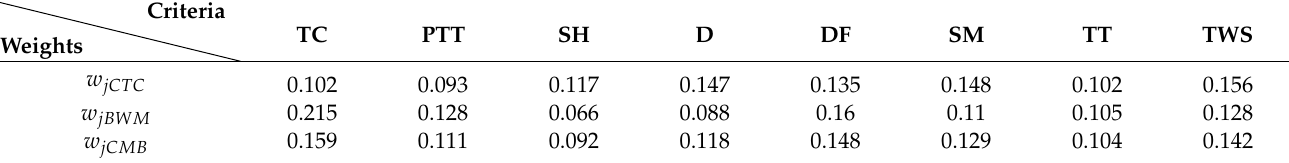
Table 6. The criteria